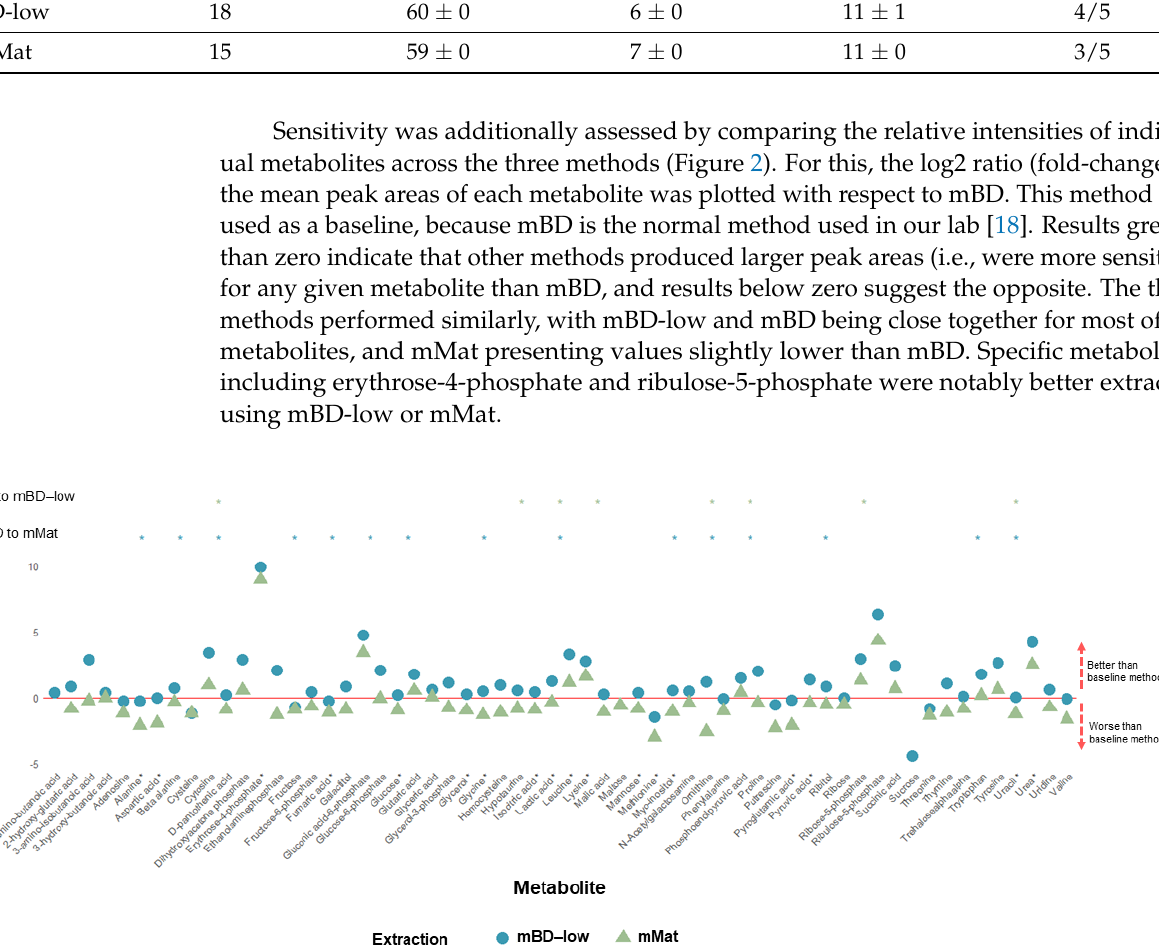
Figure 2. Bone tissue: Relative quantification represented as fold change of single metabolite peak areas using cinnamic acid normalization. Modified Bligh–Dyer (mBD) was used as a baseline (represented by the red line). Extraction sensitivity with significant variation represented in the upper pane. *: p –value < 0.05.